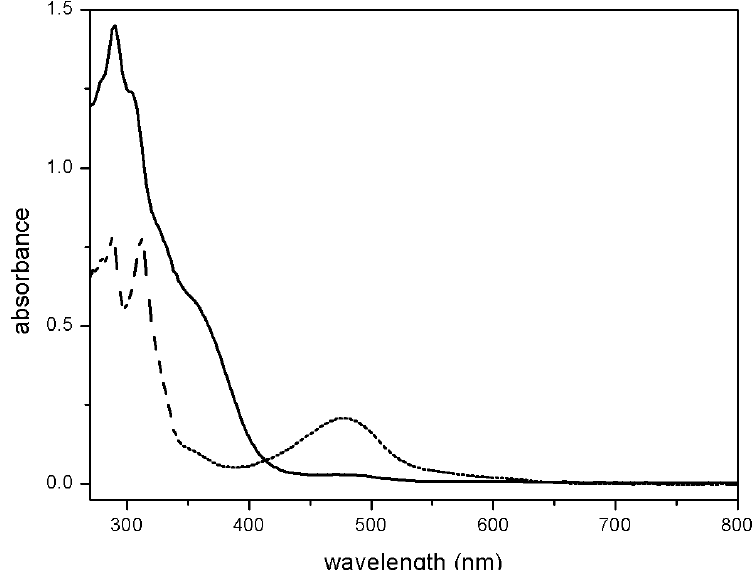
(tpy)(bpy)] 2+ (dashed line) and 2